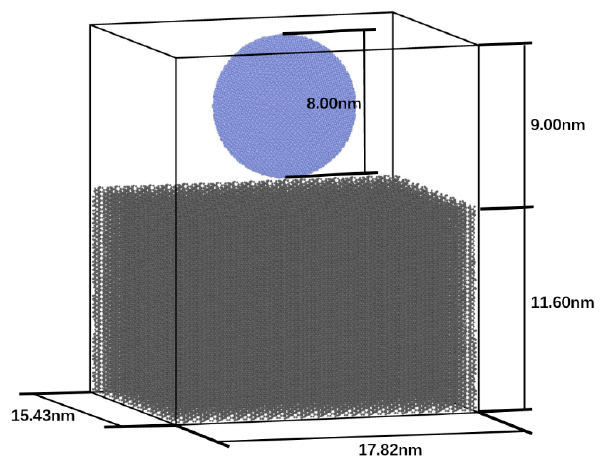
Figure 3. Schematic of simulation model of nanoindentation along the channel direction.